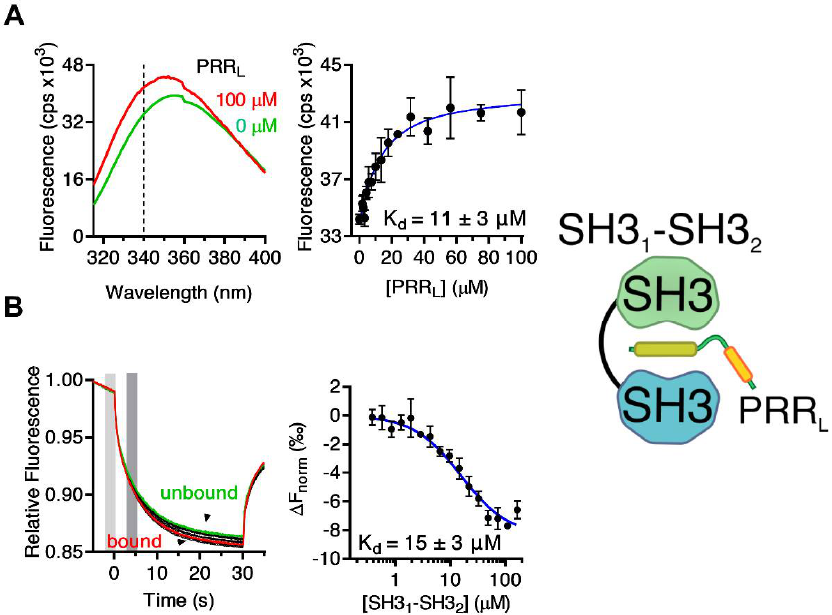
Figure 3. Binding of PRR L to SH3 1 –SH3 2 . ( A ) Intrinsic tryptophan fluorescence emission spectra of free and PRR L -bound SH3 1 –SH3 2 (left panel). In tryptophan fluorescence-based titration experiments, complex formation was followed at 340 nm (dashed line) at which the highest intensity difference was observed. A K d of 24 µ M is consistent with the hypothesized intramolecular binding of PRR to the tandem SH3 (SH3 1 –SH3 2 ) domain of Tks4. ( B ) Binding of PRR L (PTAM and PxxP are symbolized by green and yellow boxes, respectively) to SH3 1 –SH3 2 was further validated via MST. PRR L was labeled fluorescently and titrated with SH3 1 –SH3 2 . A dissociation constant of 15 µ M was determined by fitting the dose-response data to a standard fitting mode derived from the law of mass action. Left panel: MST traces, right panel: dose-response curve. The change in the normalized fluorescence ( ∆ F norm ) was calculated as the ratio of the average fluorescence in the “cold” (light gray area) and “hot” states (dark gray area) of the system. Traces corresponding to bound and unbound states of fluorescently labeled PRR L are highlighted in red and green, respectively. Error bars depict the standard deviation of three independent measurements. Table 1. Binding of the wild-type and mutant variants of PRR to SH3 1 –SH3 2 . Point mutations are denoted by red letters. Dissociation constants were determined by Trp-fluorescence-based titrations (FL) or microscale thermophoresis (MST). PRR L , PRR LP/G , PRR LP/A , and PRR LT353E were expressed in E. coli . In these fragments, four residues at the N -terminus (GSHM) are cloning artifacts. PRR S was a synthetic peptide. Errors represent the S.E. of fitting. Tks4 Fragment Sequence K d ( µ M) Method 15 ± 3 PRR L GSHMGDAKQRSPKMRQRPPPRRDMTIPRGLNLPKPPIPPQVE PRR S KMRQRPPPRRDMTIPRG PRR L P/G - FL GLNLPKPPIPPQVE GSHMGDAKQRSPKMRQRPPPRRDMTIPR- PRR LP/A FL GLNLPKAAIPPQVE GSHMGDAKQRSPKMRQRPPPRRDMEIPR- PRR LT353E 10 ± 6 FL GLNLPKPPIPPQVE To identify the proline-rich binding motif within the PRR L fragment that is responsi- ble for the interaction with SH3 1 –SH3 2 , a truncated version of PRR L containing only the